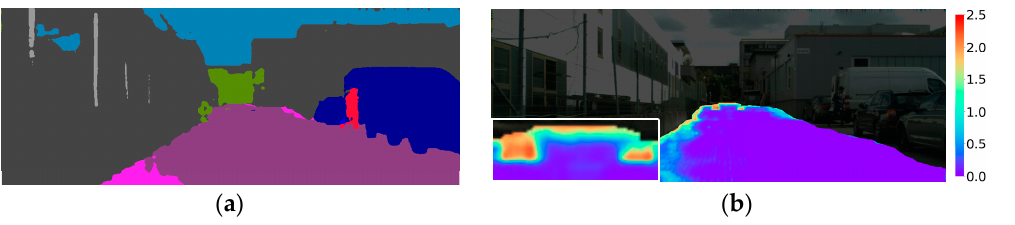
Figure 4. Uncertainty degree distribution of general semantic segmentation: ( a ) general semantic segmentation; ( b ) uncertainty degree distribution.